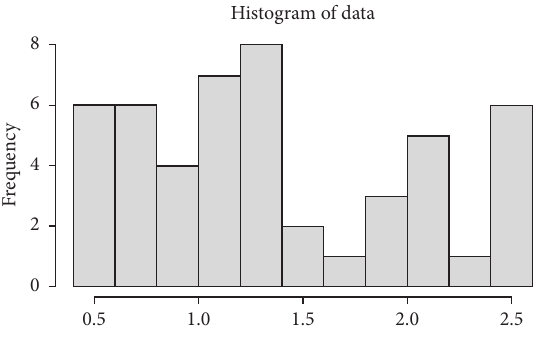
Figure 6: Histogram of Stock prices.